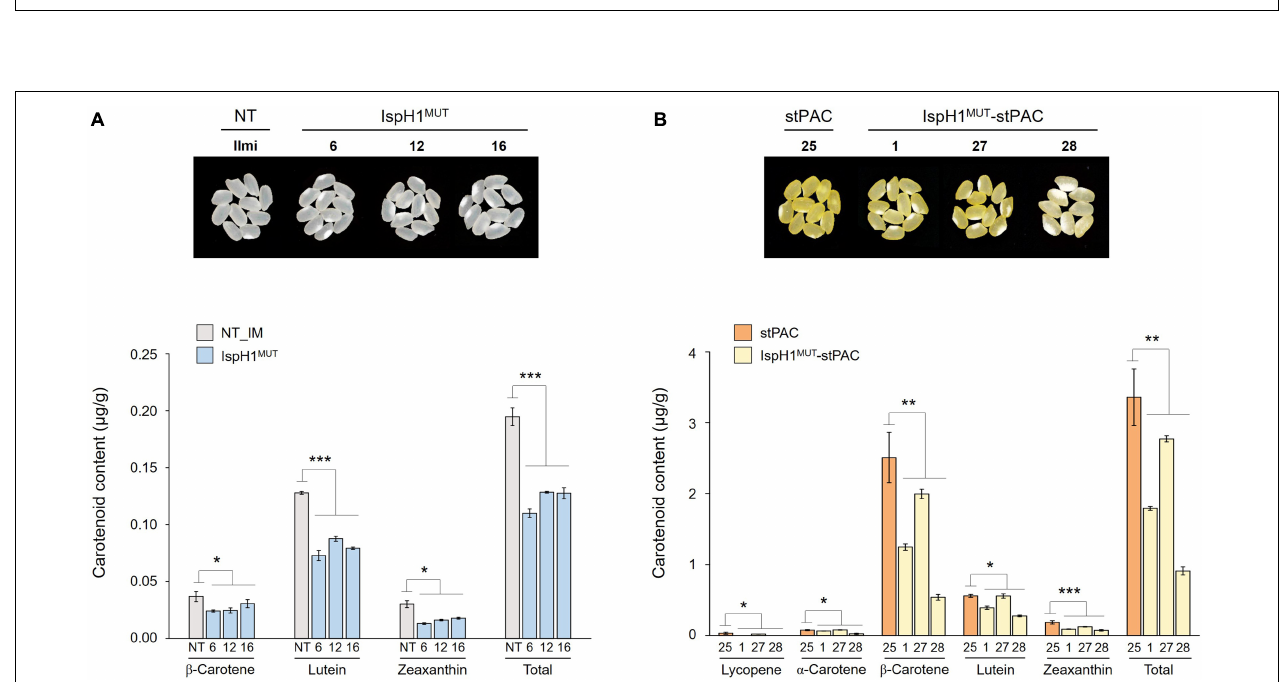
FIGURE 7 | Color phenotypes and carotenoid levels in the rice seeds of IspH1 MUT (A) and IspH1 MUT -stPAC (B) transgenic lines. Colors of mature seed harvested 60 days after flowering were compared, dried for 2 weeks at room temperature, threshed, dehusked, and polished in the homozygous T4 generation. Carotenoid contents were analyzed using high-performance liquid chromatography (HPLC), and all data are represented as the mean ± SE of three independent measurements. Statistical analyses were performed using a one-tailed, and significant differences were indicated by a p -value (* p < 0.05, ** p < 0.01, and *** p < 0.001).